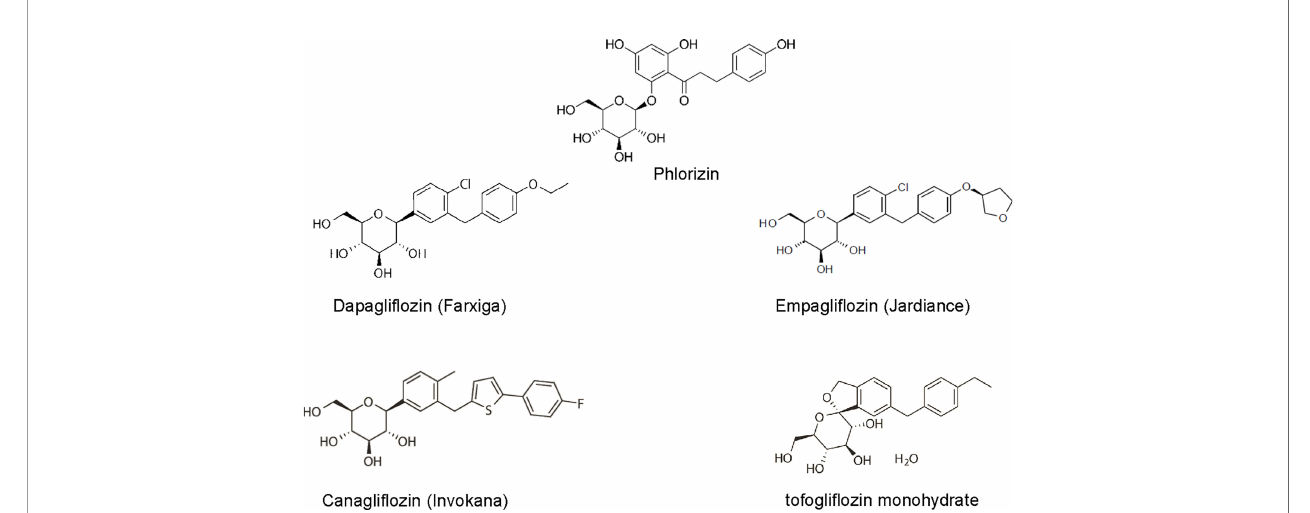
FIGURE 1 | The 2-D view of chemical structure of various SGLT2 inhibitors, including phlorizin, dapagli fl ozin, empagli fl ozin, canagli fl ozin, tofogli fl